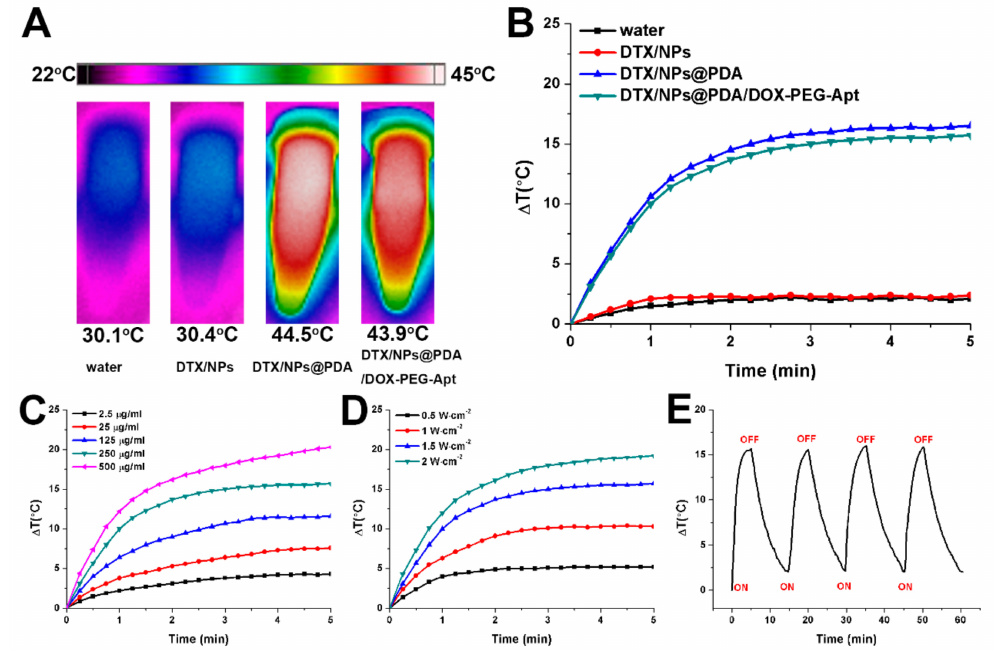
Figure3. ( A )IRthermalimageofwater, DTX / NPs, DTX / NPs@PDA,andDTX / NPs@PDA /